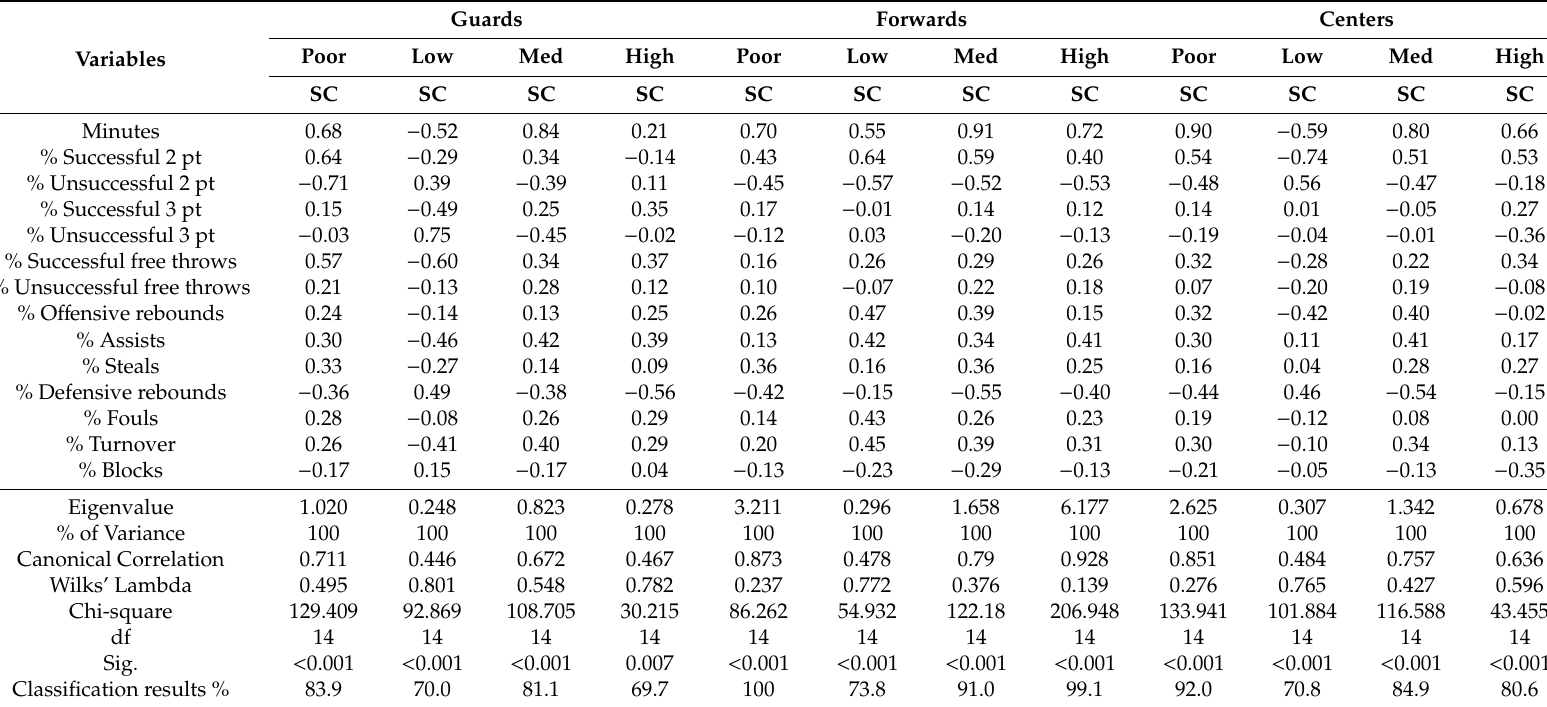
Table 4. Discriminant function structure coe ffi cients (SC) and tests of significance for each game metric that di ff erentiated foreign and national Guards, Forwards, and Centers, based upon poor, low, medium, and high team